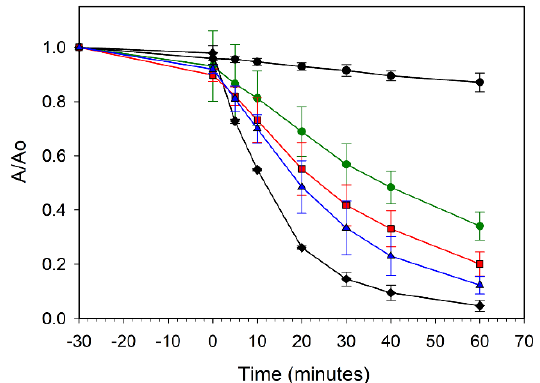
Figure 9. UV photooxidative degradation of methylene blue dye in air using ZZ-ZnO (black diamonds), ZZ-Ni(1%):ZnO (red squares), ZZ-Ni(5%):ZnO (blue triangles), and ZZ-Ni(10%):ZnO (green circles). A blank methylene blue solution without catalyst is also shown (black circles).